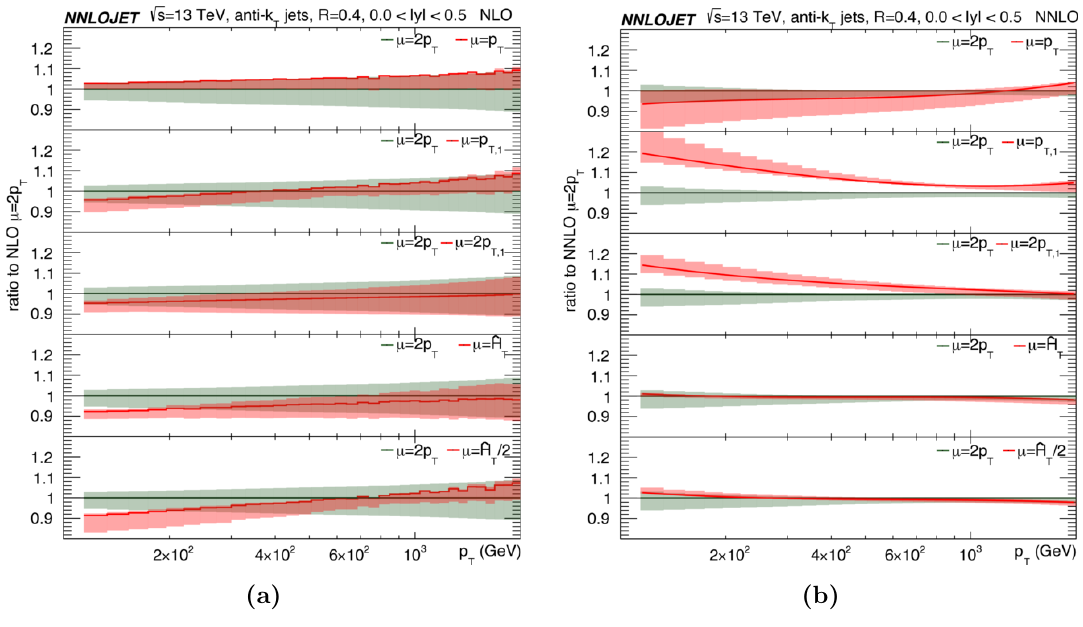
Figure 20 . Ratio of 13 TeV single jet inclusive cross sections to the (cid:22) = 2 p T scale choice at (a) NLO and (b) NNLO with R = 0 : 4 and CMS